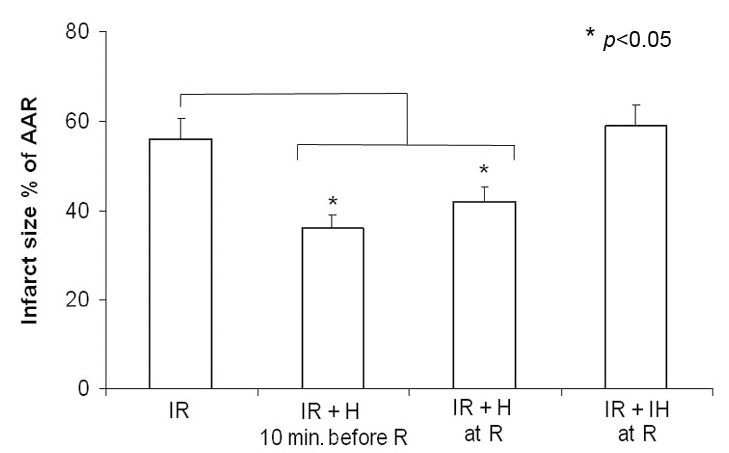
FIGURE 5. Myocardial infarction size after 30-min ischemia and 60-min reperfusion (IR) expressed as percent of the area-at-risk (AAR), evaluated by computer-assisted morphometry on nitroblue tetrazolium–stained hearts. H: histaminase (80 IU/kg b.w.), IH: semicarbazide-inactivated histaminase (same dose). Results are expressed as mean ± SEM of eight